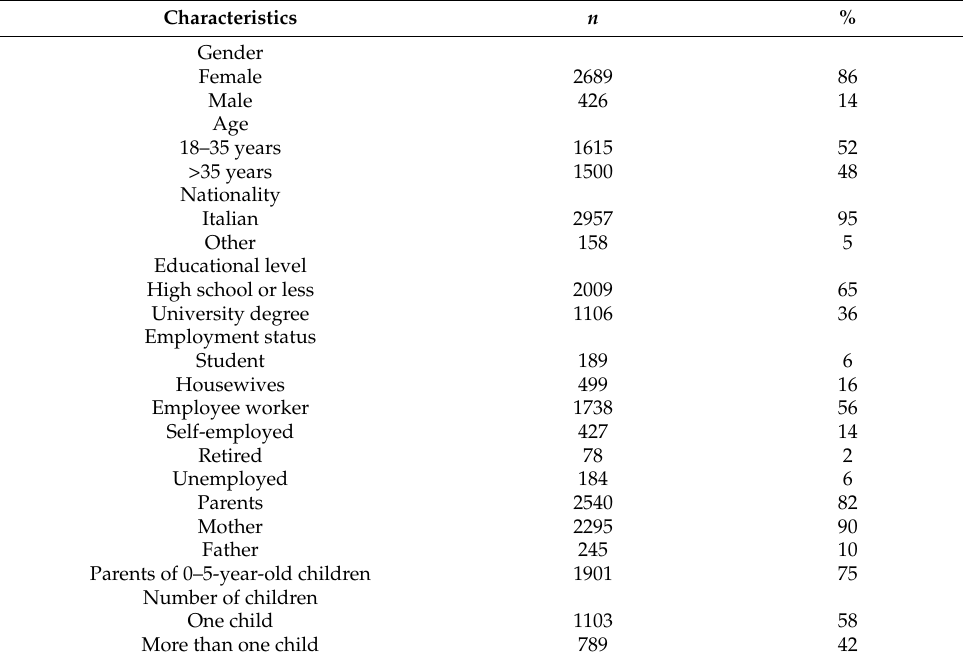
Table 1. Socio-demographic characteristics of participants.